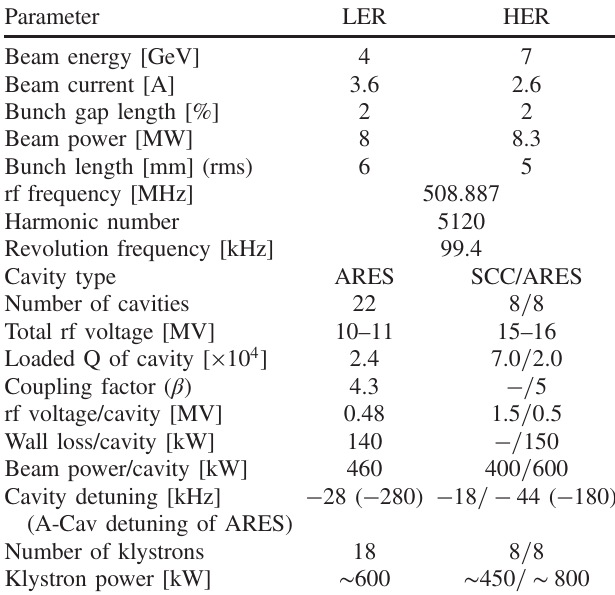
TABLE IV. SuperKEKB parameters for the estimation of the bunch gap transient